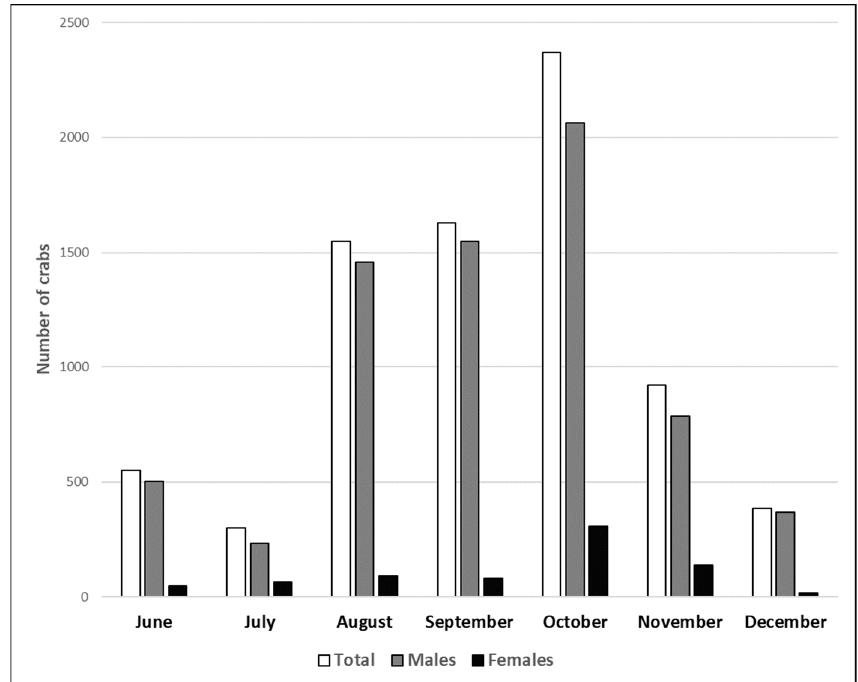
Figure 3. Monthly capture (total number, total males, and total females) of Blue Crab Callinectes sapidus in 15 wire crab traps in the Parila lagoon (Eastern Adriatic, Croatia) during June-December crabbing season.